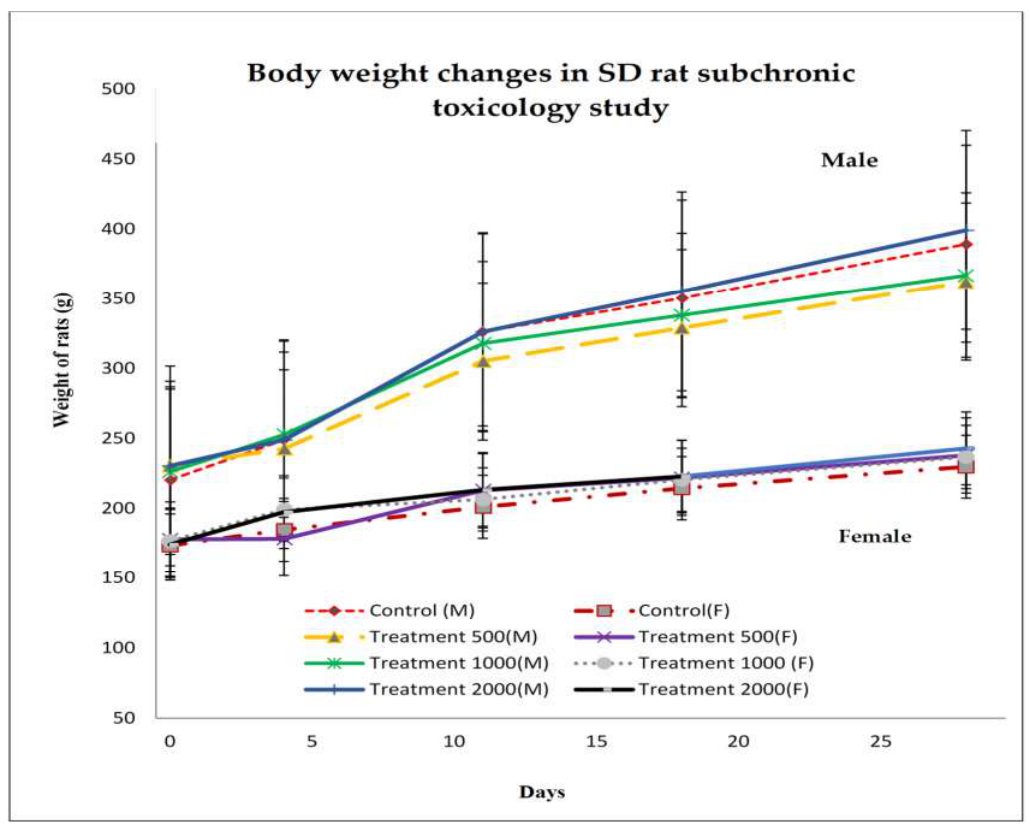
Figure 2. Average body weight gain for male (A) and female (B) rats administrated palm puree at 0 mg kg − 1 ( ♦ ), 500 mg kg − 1 ( ∆ ), 1000 mg kg − 1 ( • ), and 2000 mg kg − 1 ( | ) by oral gavage during a 28 d subchronic toxicity study ( n = 5 animals per group). Data are means ± SD for each group. Data are means ± SD for groups of five animals/sex/dose.